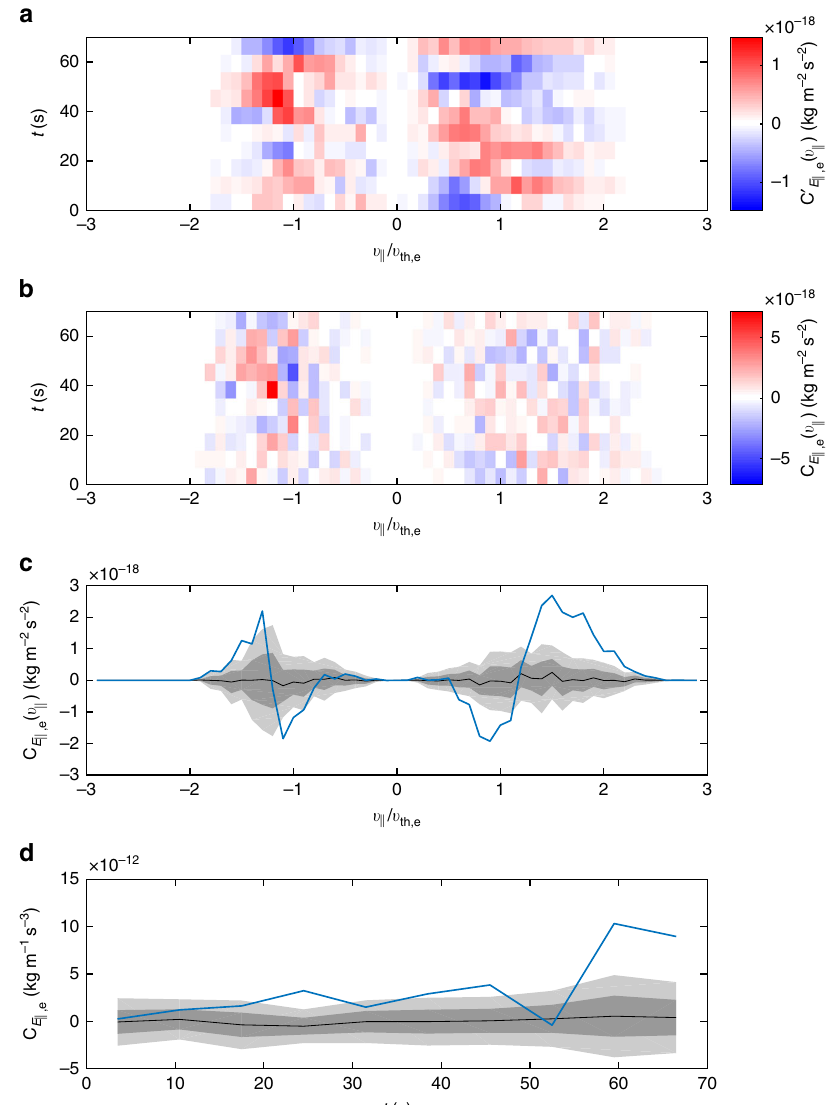
Fig. 4 Reduced energy transfer rate measurements using a phase-randomised electric fi eld. a , b Same as in Fig. 2 except with randomised E || . c Energy ð v Þ (blue) with the mean of the ensemble of phase randomisations (black) and shaded areas representing ±1 σ (dark grey) and ±2 σ (light transfer rate C E jj jj ; e grey). d Same for C E (integrated over v jj ) shown as a function of time jj ; e